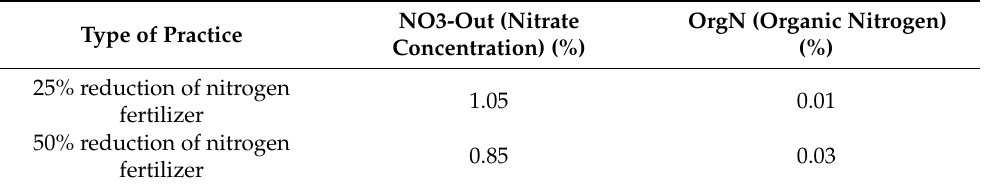
Table 7. Percentage reduction in the concentration of organic nitrogen and nitrate at varying reduc- tions of